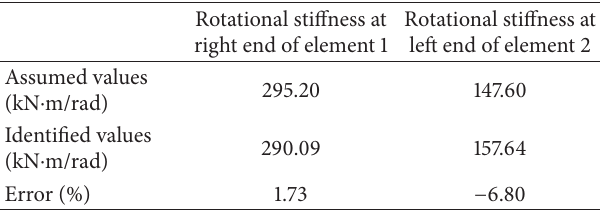
Table 3: Assumed and identified rotational stiffness for single damage case.